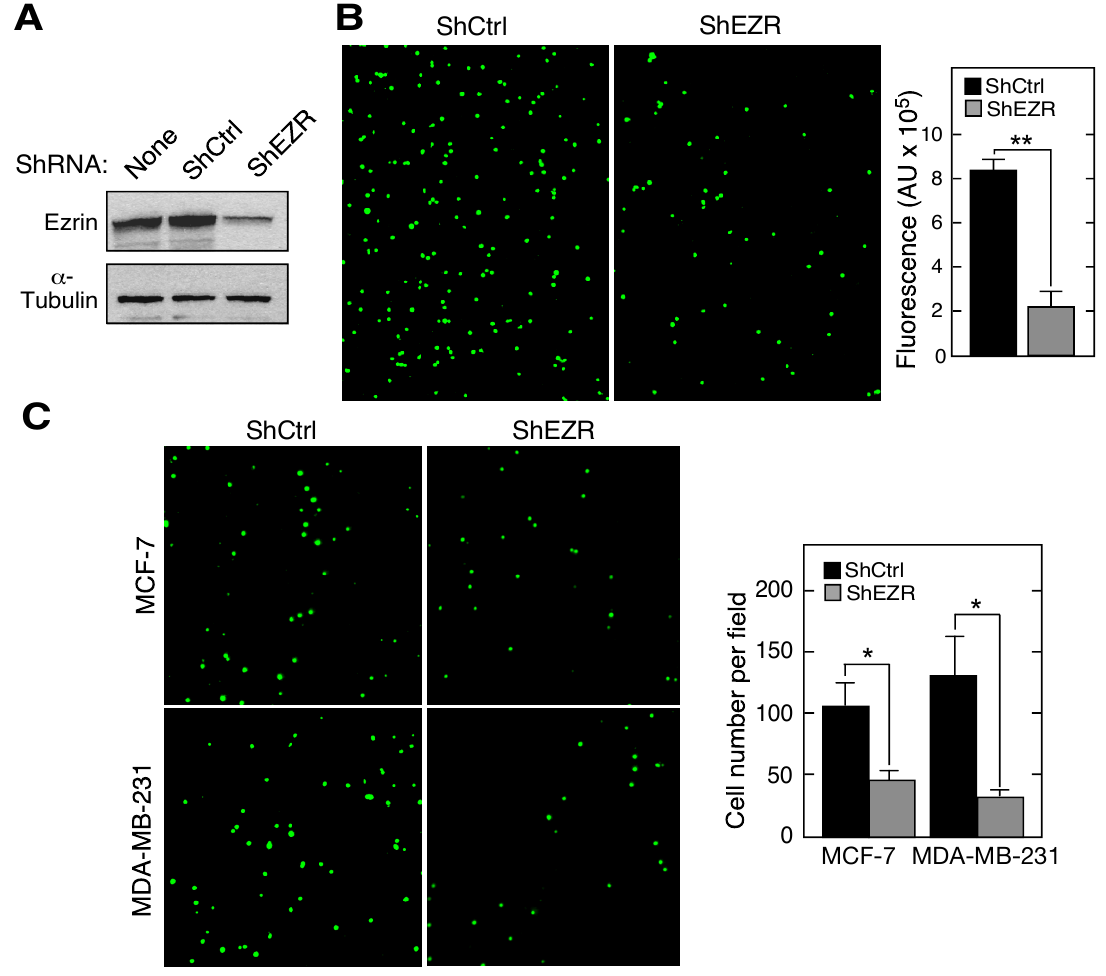
Figure 1. Role of myeloid cell ezrin in adhesion to endothelial cells and transmigration. ( A ) Immunoblot of lysates from THP-1 cells subjected to lentivirus-mediated stable knockdown with shRNA targeting ezrin (ShEZR) or control shRNA (ShCtrl). ( B ) Calcein-AM-labeled ShCtrl and ShEZR THP-1 cells were incubated with human umbilical vein endothelial cells (HUVEC) for 3 h and cell adhesion was determined by immunofluorescence imaging (left) and by the quantification of fluorescence intensity (right). ( C ) The chemoattraction of calcein-AM-labeled ShCtrl and ShEZR THP-1 cells towards conditioned medium (CM) from breast cancer cell lines was determined by a trans-well migration assay. Mean ± standard deviation; * and ** indicate p < 0.05 and 0.01,